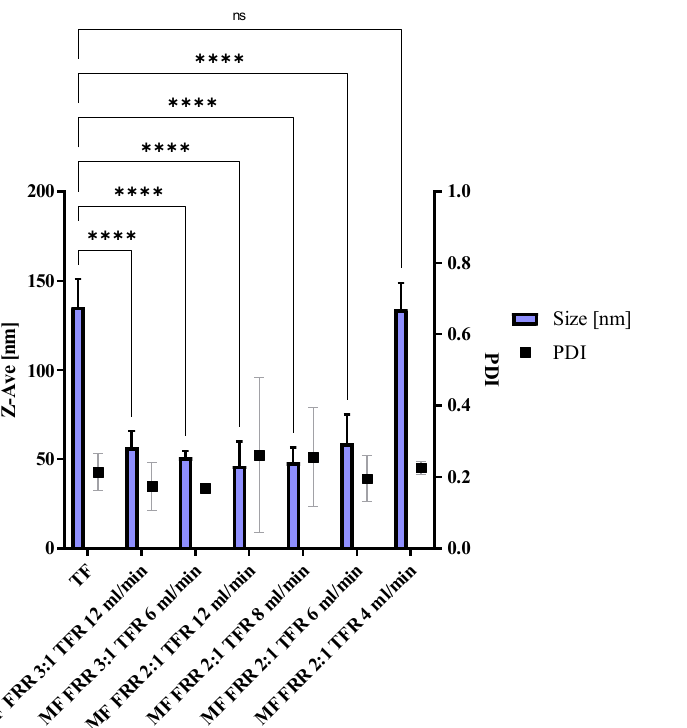
Figure 1. Size and polydispersity indices of liposomes prepared by a thin-film layer rehydration method and according to the microfluidics protocol, mean ± SD, N = 3. Unpaired Welch’s t -test. **** indicates p < 0.0001, ns shows non-significance. The test is meant to show differences among samples manufactured with microfluidics compared to the thin-film rehydration-manufactured particles control.